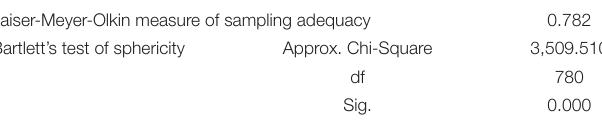
TABLE 2 | Kaiser Meyer Olkins (KMO) results (KMO and Bartlett’s